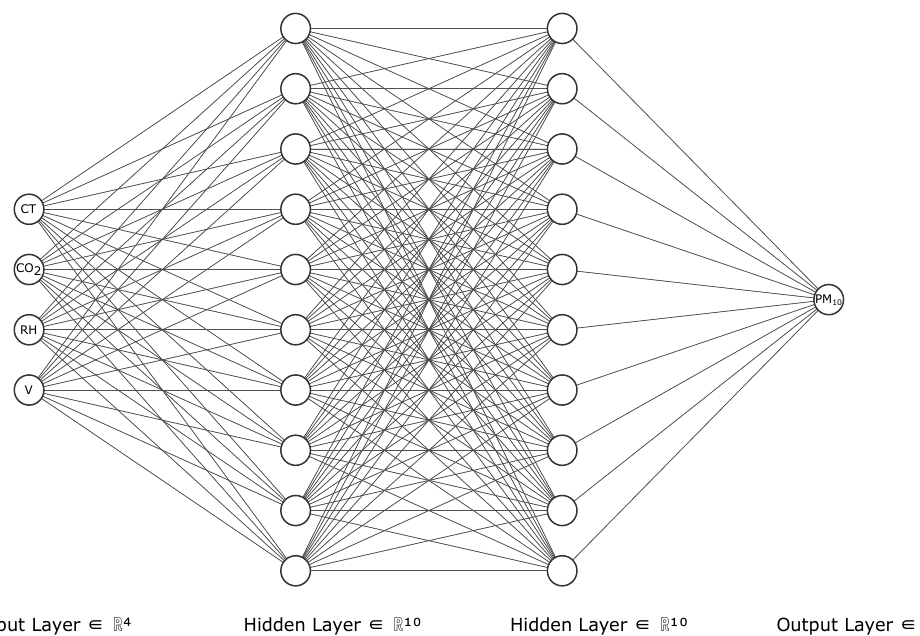
Figure 6. Feedforward Neural Network (FFNN) schematic with 4 inputs, 2 hidden layers @10 nodes. The schematic of the Feedforward Neural Network Model for classification (Proba- bilistic Neural Network) using the same inputs, two pattern (hidden) layers and PM10 as output is shown in Figure 7. The number of nodes in the pattern layers are equal to the number of training points in the dataset. In the first pattern layer, the training data set uses 40% of the data, while the second layer utilizes 28% of the data set.